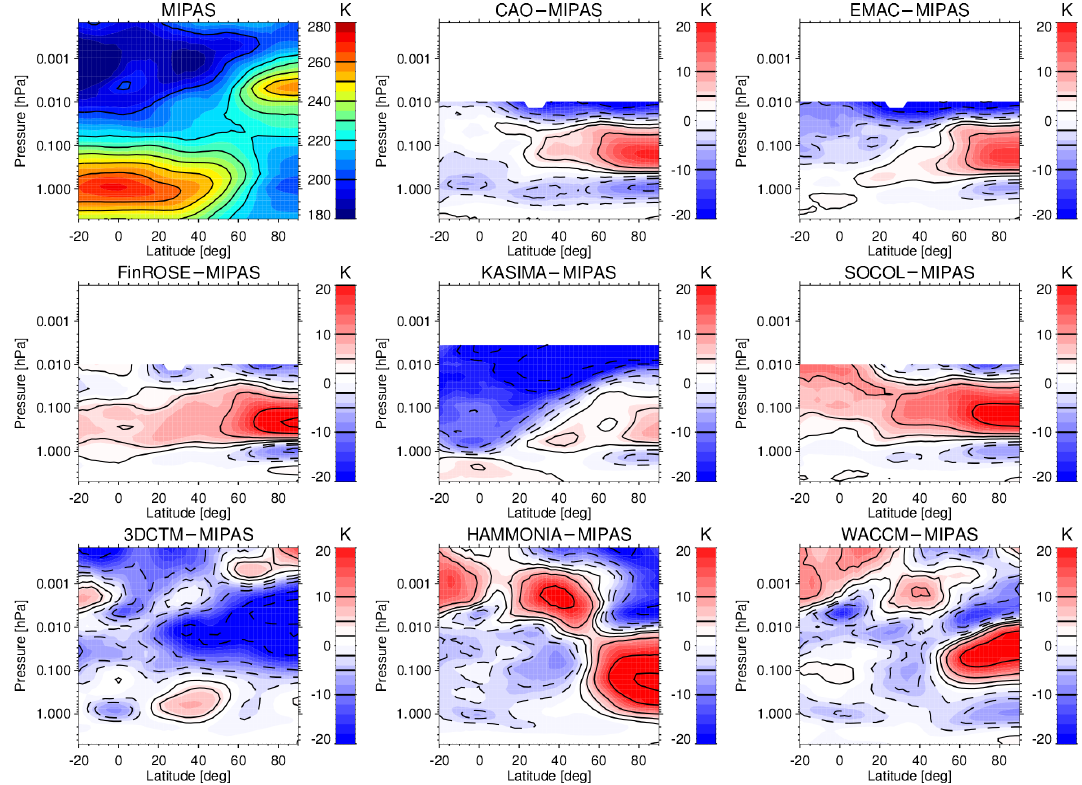
Figure 19. MIPAS-UA and modelled NH zonal mean temperature distribution on 15 February